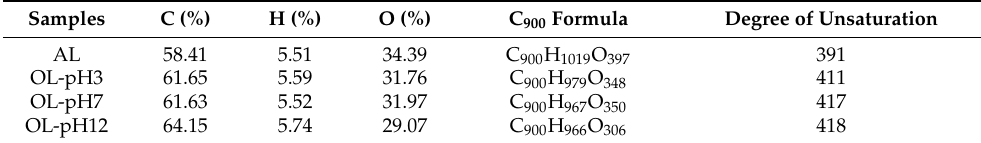
Table 1. Elemental content and degree of unsaturation of alkali lignin before and after ozone pretreat-